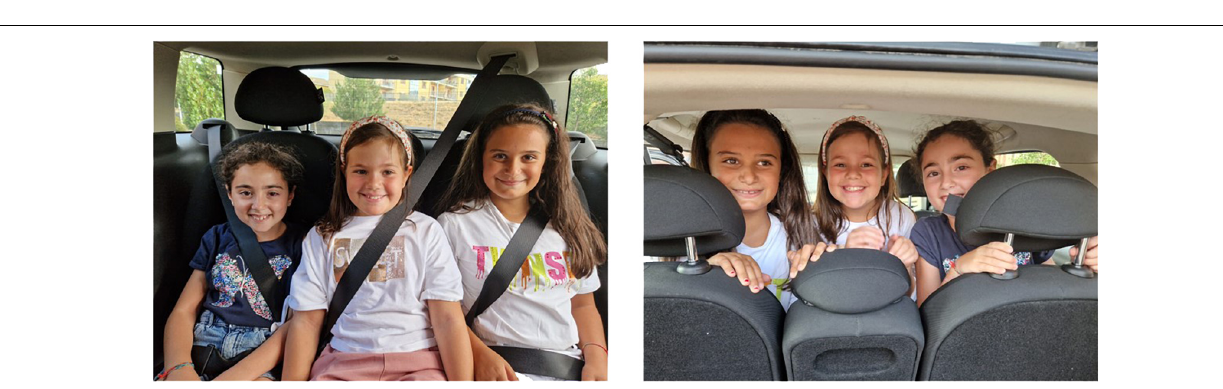
FIGURE 6 | The safety of children in the